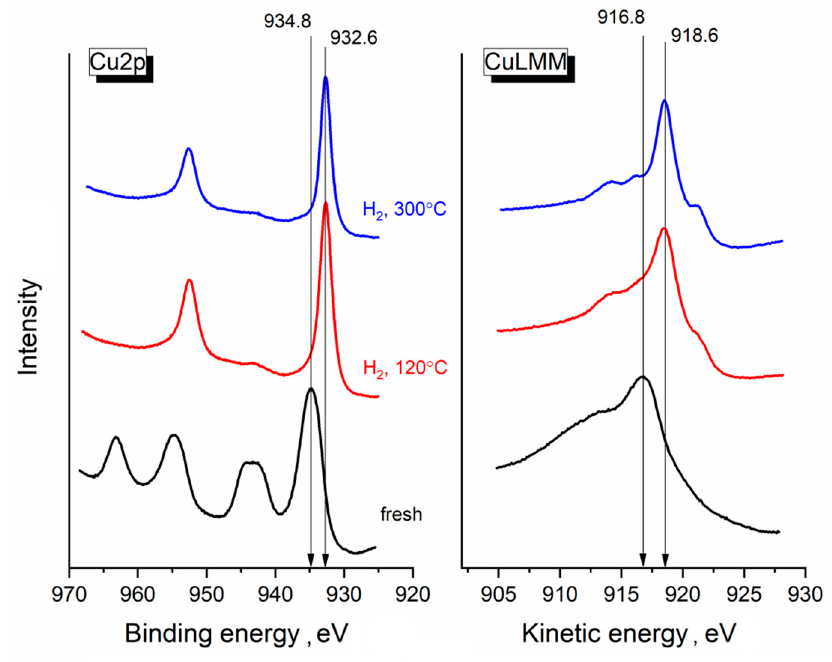
Figure 5. Cu2p XP spectra and CuLMM Auger spectra of the CuAl sample calcined at 650 ° C and reduced at 120 and 300 ° C.